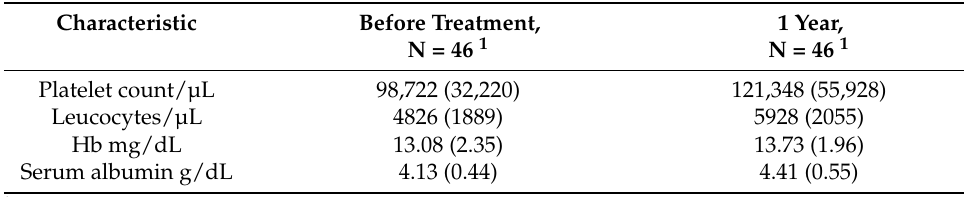
Table A1. Serum markers values before the treatment and after one year. Characteristic